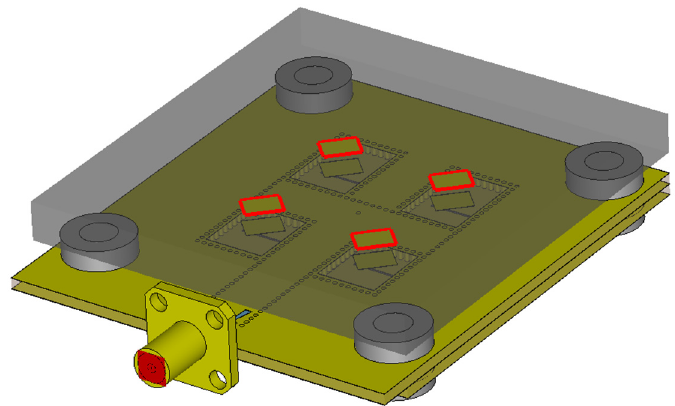
Figure 15. Antenna array with parasitic patches (bound in red).